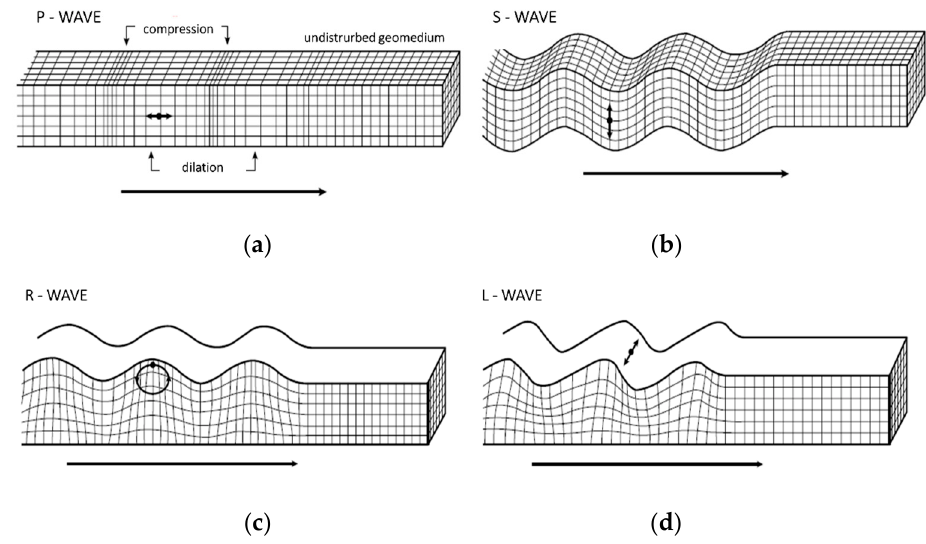
Figure 1. Seismic wave propagation: ( a ) longitudinal P-wave, ( b ) shear S-wave, ( c ) Rayleigh R-wave and ( d ) Love L-wave, modified from [24].